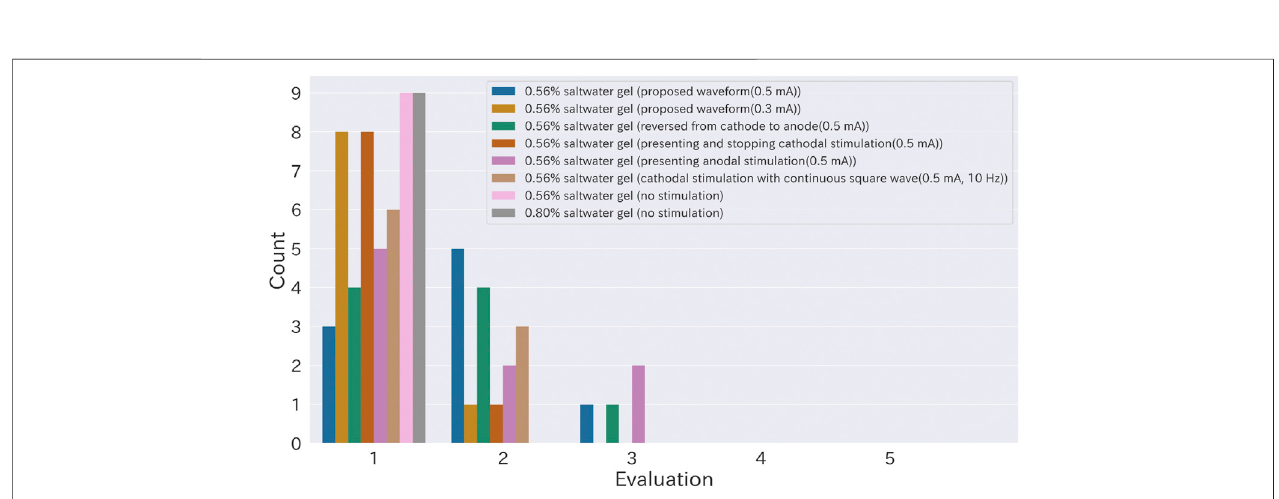
FIGURE 7 | Evaluation results of discomfort for each condition in the preliminary experiment 1. The numerical values indicate 1: none, 2: low (not bothersome), 3: mild (bothersome in daily life, but not unbearable), 4: moderate (bearable in testing, but unbearable in daily life), and 5: severe (unbearable).